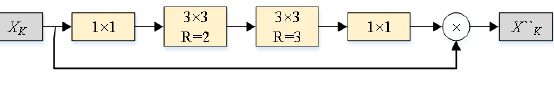
Fig. 5. Spatial attention